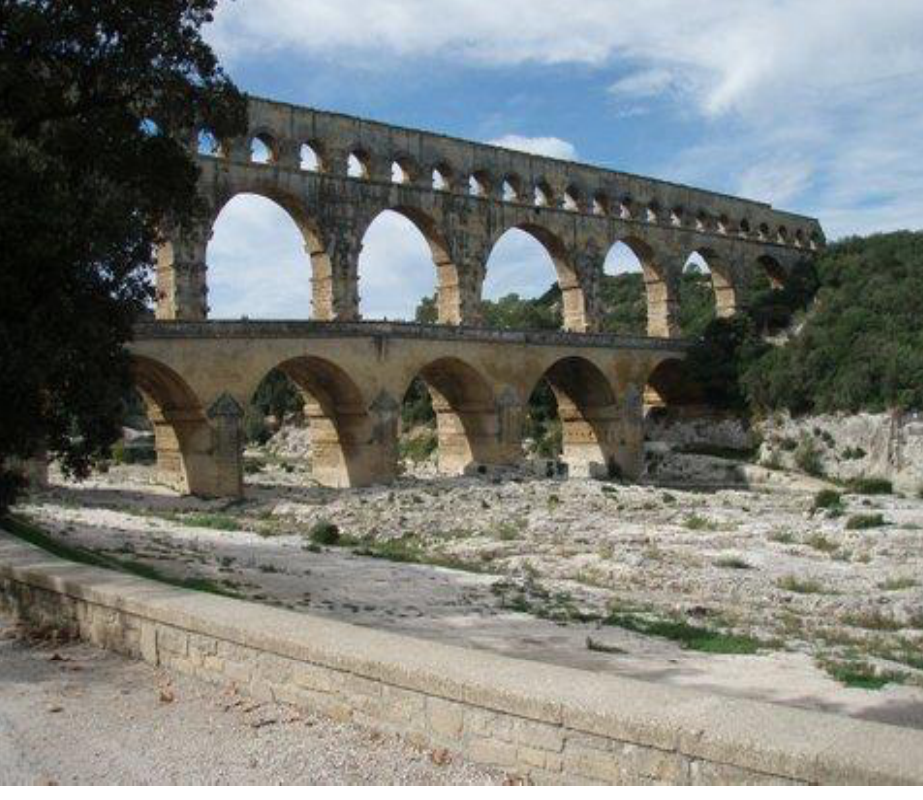
Figure 35. The Roman Pont du Gard Aqueduct Bridge. Photo by author.